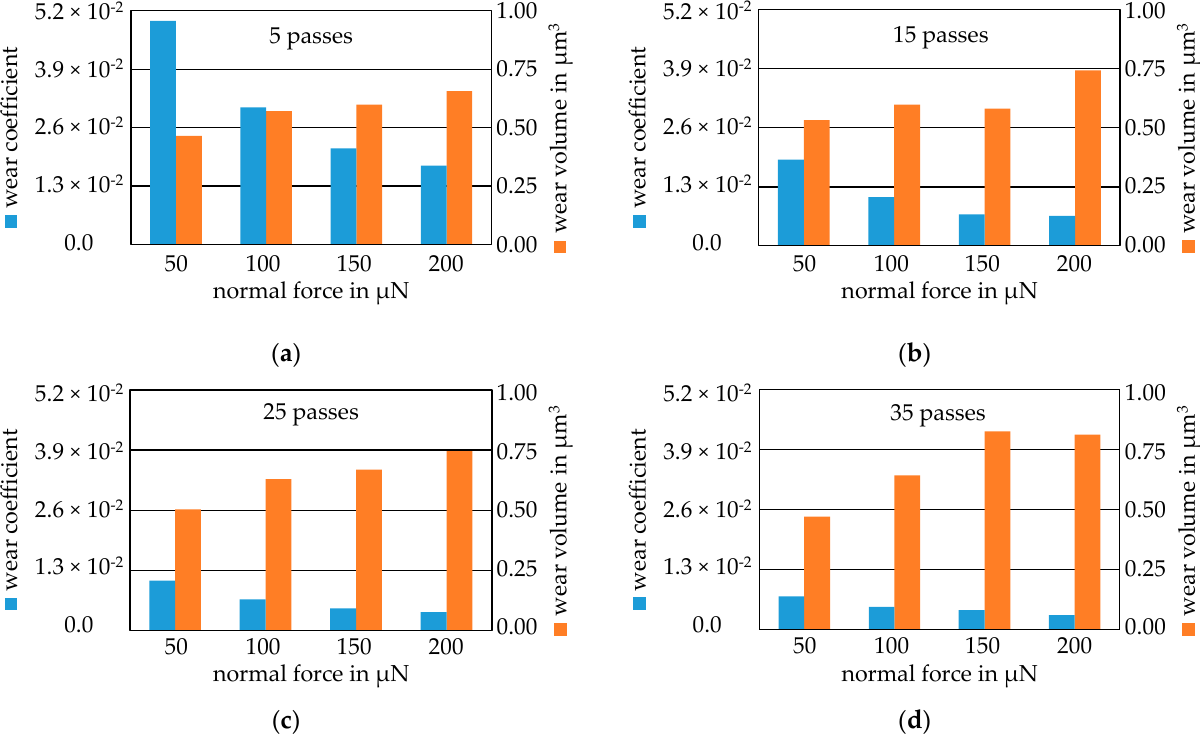
Figure A3. Development of the average wear volumes and average coefficients of wear over the normal forces of the Mo ‐ coating. ( a ) 5 passes; ( b ) 15 passes; ( c ) 25 passes; ( d ) 35 passes.